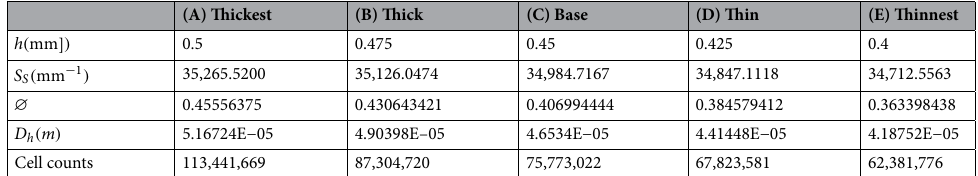
Table 1. Summary of geometric variables of the five mono-size pack models. Ref: the final cell numbers of the unstructured tetrahedral grid systems of each model were identified using trials of different grid resolutions.